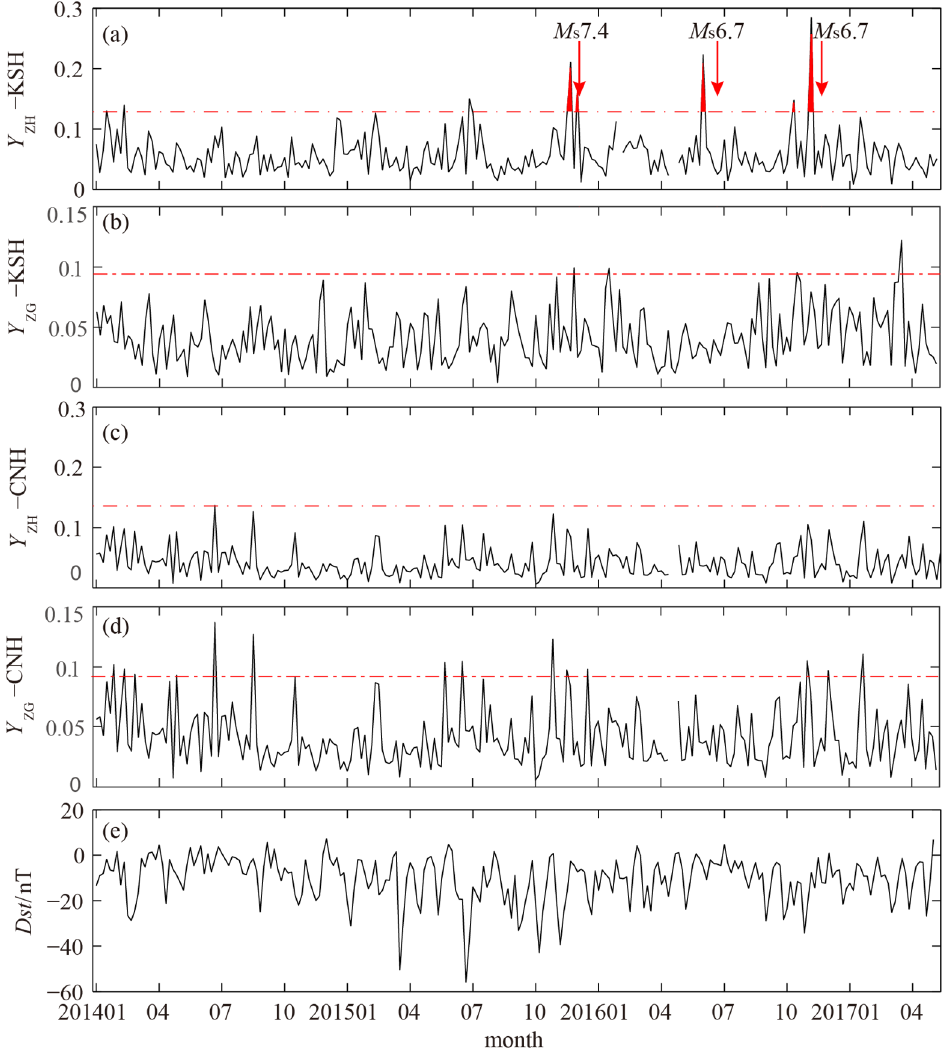
Figure 5. Polarization ratios of Y ZH at ( a ) KSH, ( c ) CNH stations and Y ZG at ( b ) KSH, ( d ) CNH observatories within 0.003–0.02 from 2014 to 2017 and ( e ) Dst index.